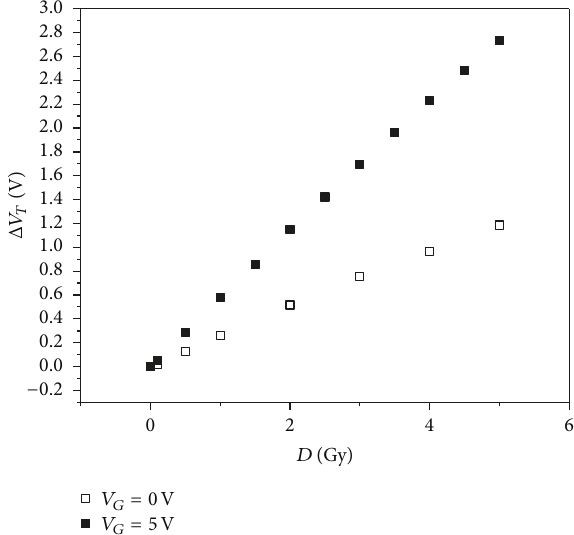
Figure 5: Δ𝑉 𝑇 during gamma-ray irradiation with zero and +5 V gate